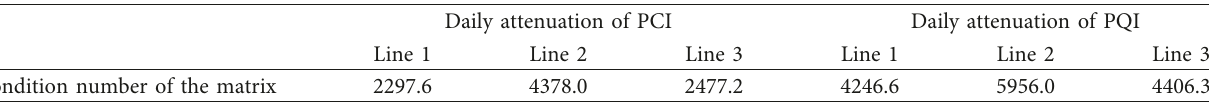
Table 8: Condition number of the GM (1, 1) model matrix using the daily attenuations of PCI and